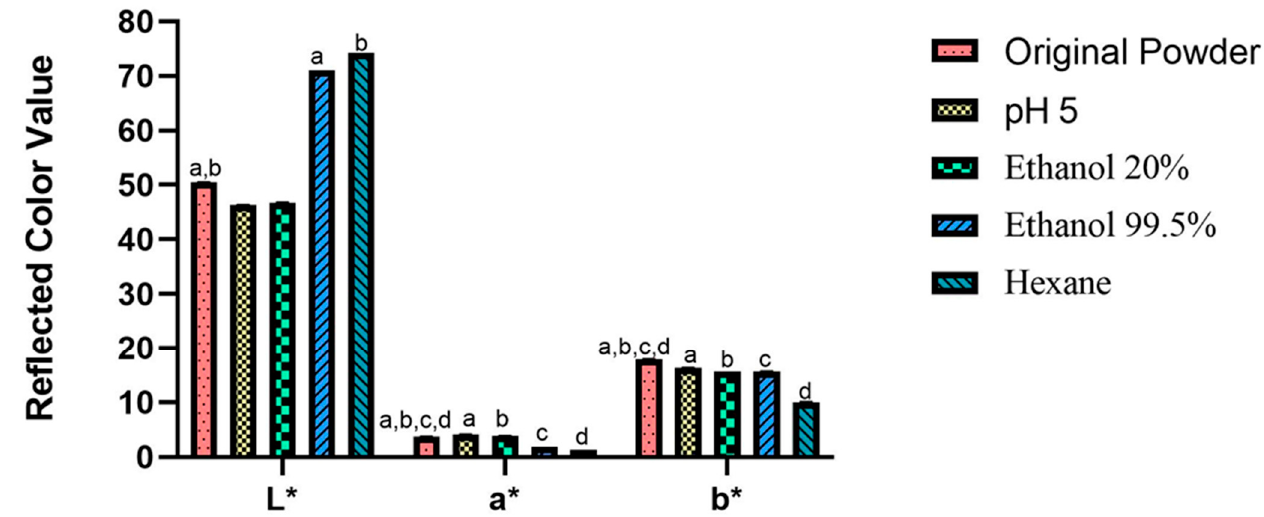
Figure 5. Difference in powder colors using CIELAB. Letters represent significant difference ( p < 0.05). L *—a = ethanol 99.5% vs. original powder, b = hexane vs. original powder. a * and b *—a = pH 5 vs. original powder, b = ethanol 20% vs. original powder, c = ethanol 99.5% vs. original powder, d = hexane vs. original